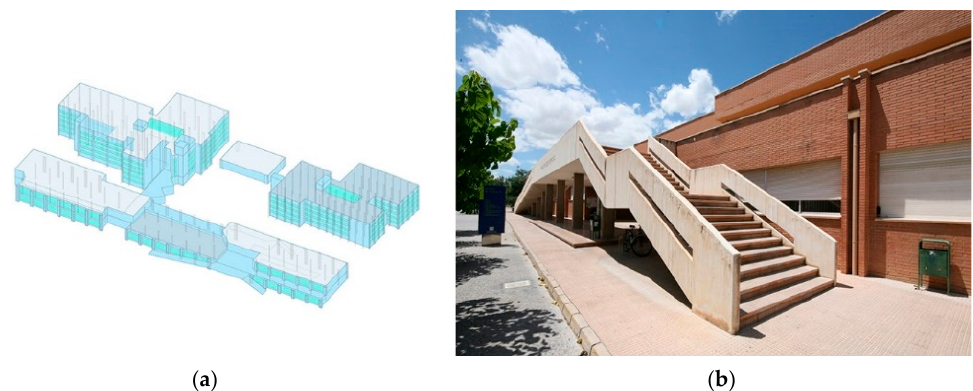
Figure 11. FS: Materiality scheme ( a ) and access ( b ). Drawing: Carlos Pastor García. Photo: Courtesy of UA’s Technical Office.